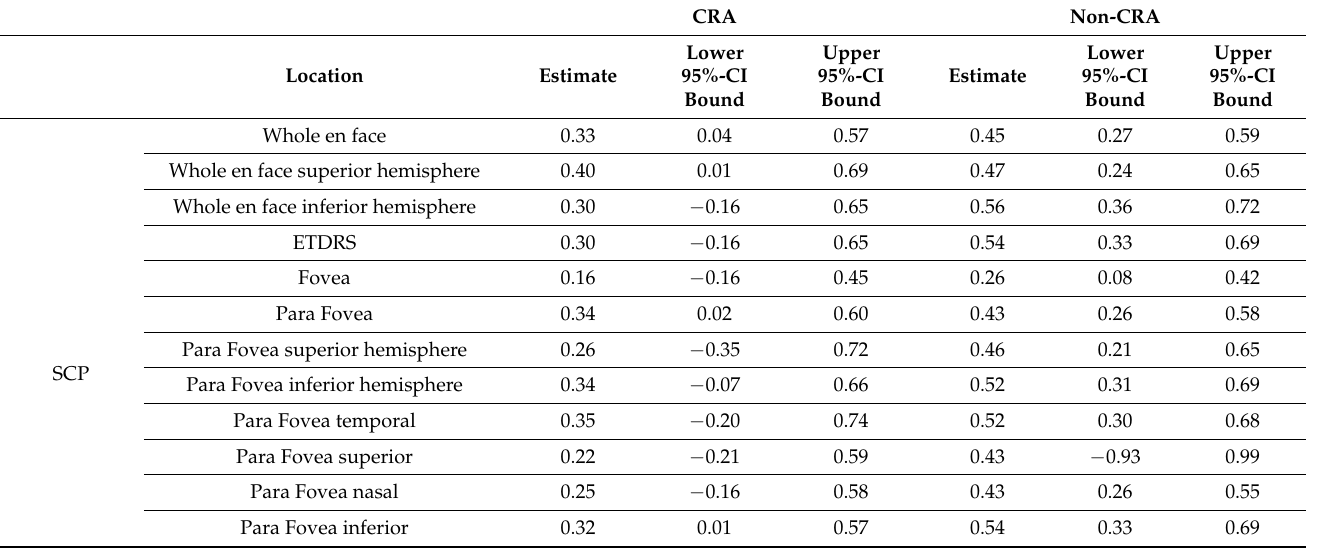
Table 5. Correlation analysis between the FD reduction and the severity of glaucoma for the CRA and non-CRA cohorts. CRA